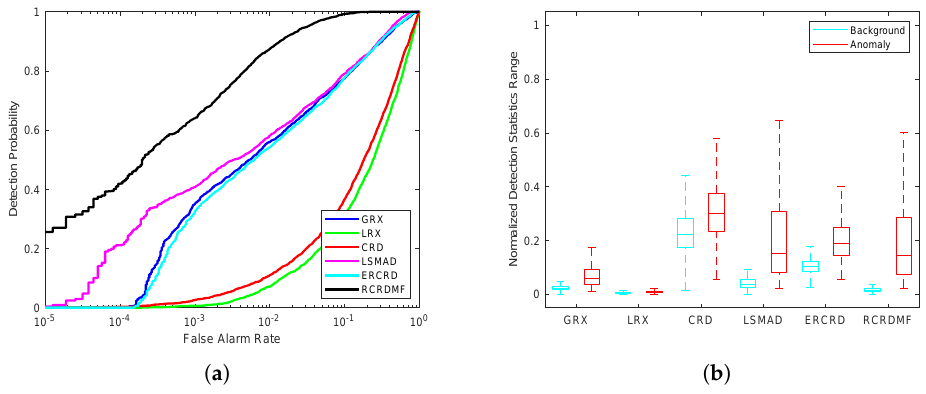
Figure 12. Detection accuracy evaluation for the Cri dataset. ( a ) ROC curves. ( b ) Normalized background-anomaly separation